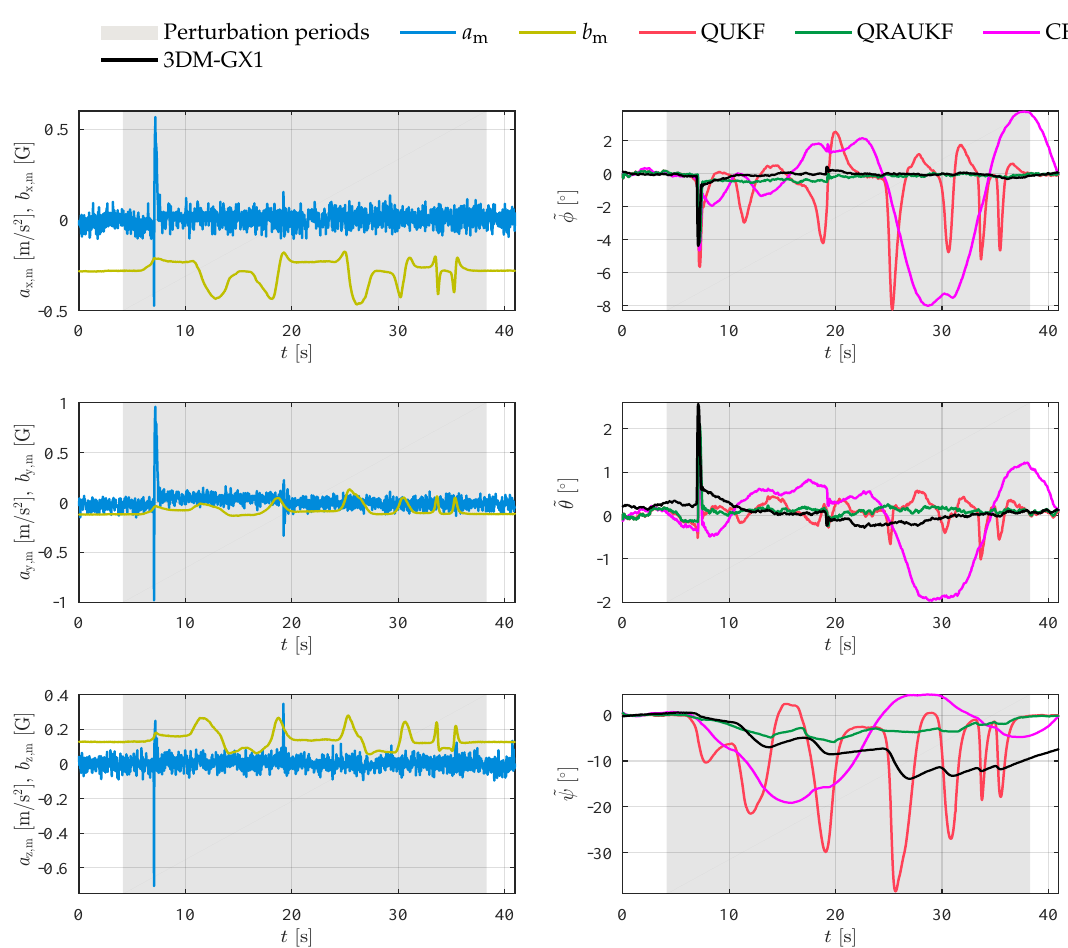
Figure 6. Results for slow magnetic disturbances experiment (third experiment), scenario (ii). In the left column, linear acceleration a m and magnetic field b m measurements, in the right column, the attitude